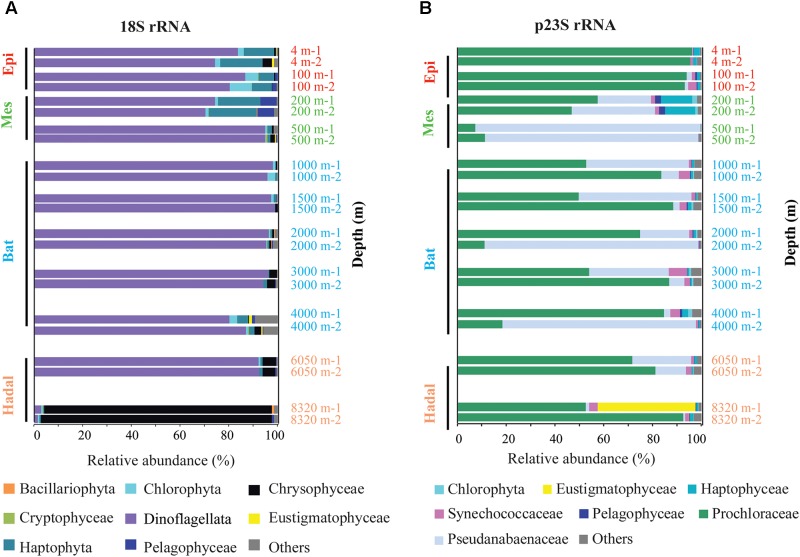
Vertical distribution patterns of PN community composition in the Challenger Deep. (A) 18S rRNA gene assemblage and (B) plastid 23S rRNA gene assemblage. “1” and “2” at the end of depth were used to distinguish the duplicates.